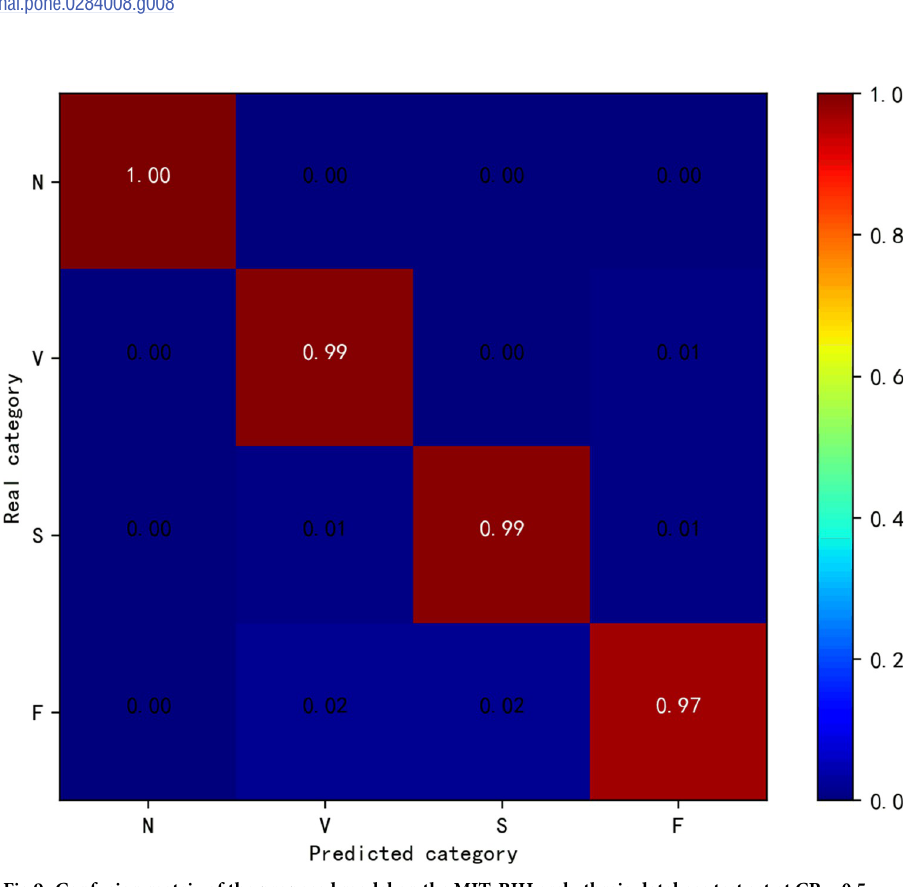
PLOS ONE | https://doi.org/10.1371/journal.pone.0284008 April 4,